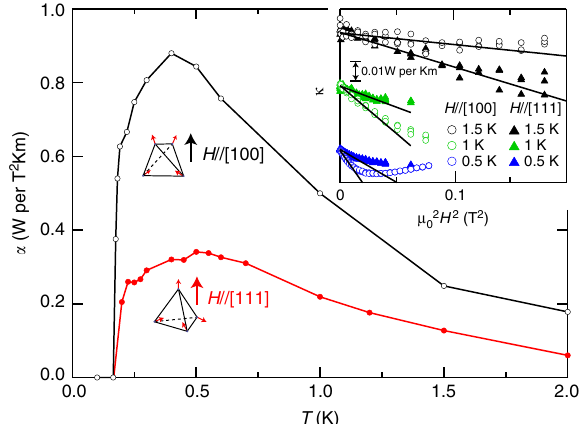
Figure 4 | H 2 reduction rate of monopole thermal conductivity as a function of temperature. Temperature dependence of the initial slope of k ( H ) determined by fitting k ( H ) ¼ k (0) (cid:3) a H 2 , for H || [0, 0, 1] and [1, 1, 1]. Inset shows k ( H ) plotted as a function of H 2 at very low